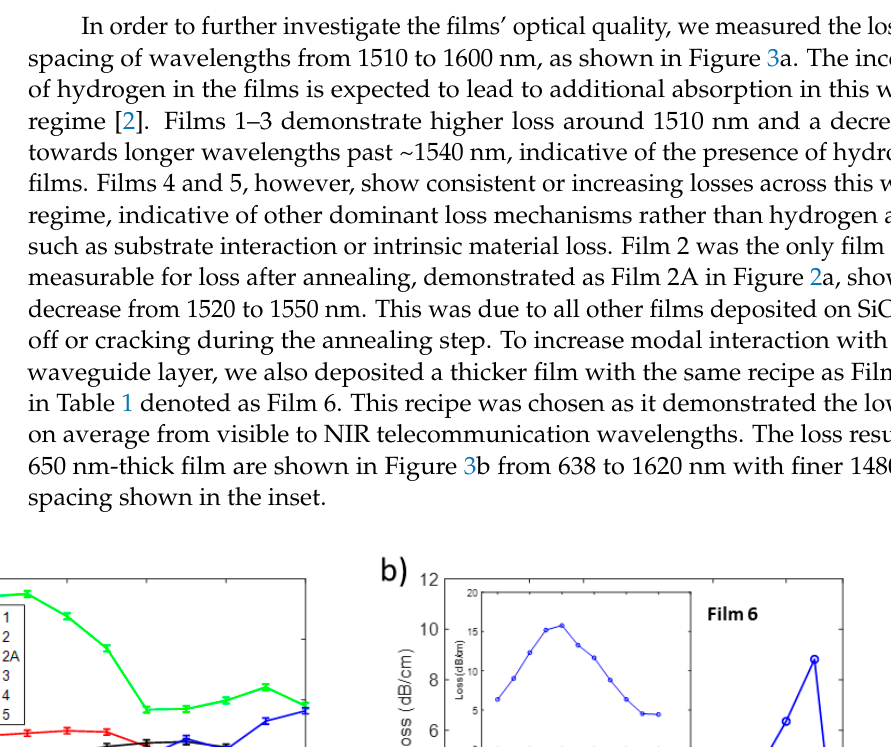
Figure 2. Optical loss determined via prism coupling at various wavelengths in the visible to infrared for each SiO x N y :H z film. The films were deposited on 6 μ m thermally grown SiO 2 layers on Si substrates. Connecting lines are to help guide the eye. Inset: red light streak from Film 3 visible during 638 nm loss measurement.